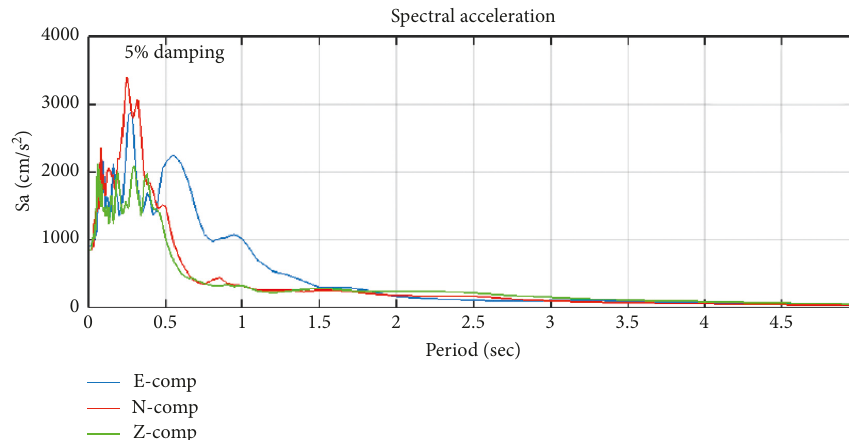
Figure 2: Spectral acceleration history, northern Norcia Italy earthquake of 30 Oct 2016